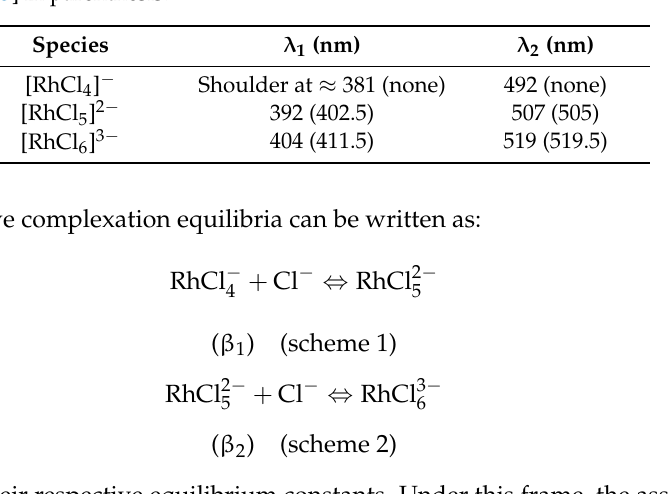
Table 1. Values of the local absorption maxima for the three Rh-chloro complexes as derived from this work. Values from [5] in